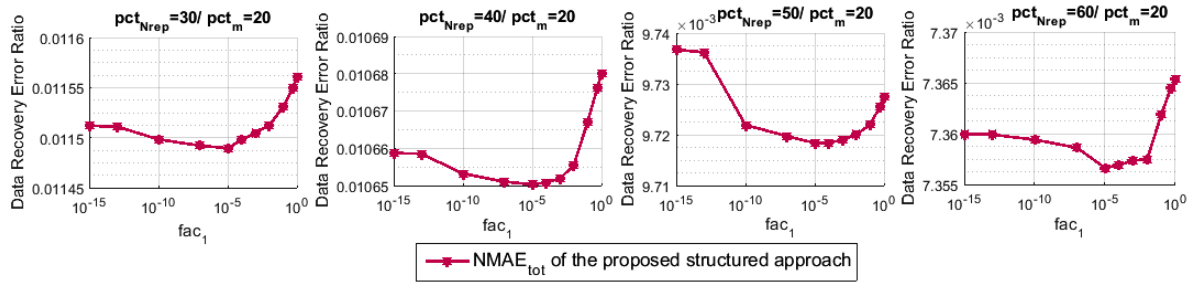
Figure 4. NMAE tot for the proposed technique with respect to the regularization parameter f ac 1 of the minimization (11).